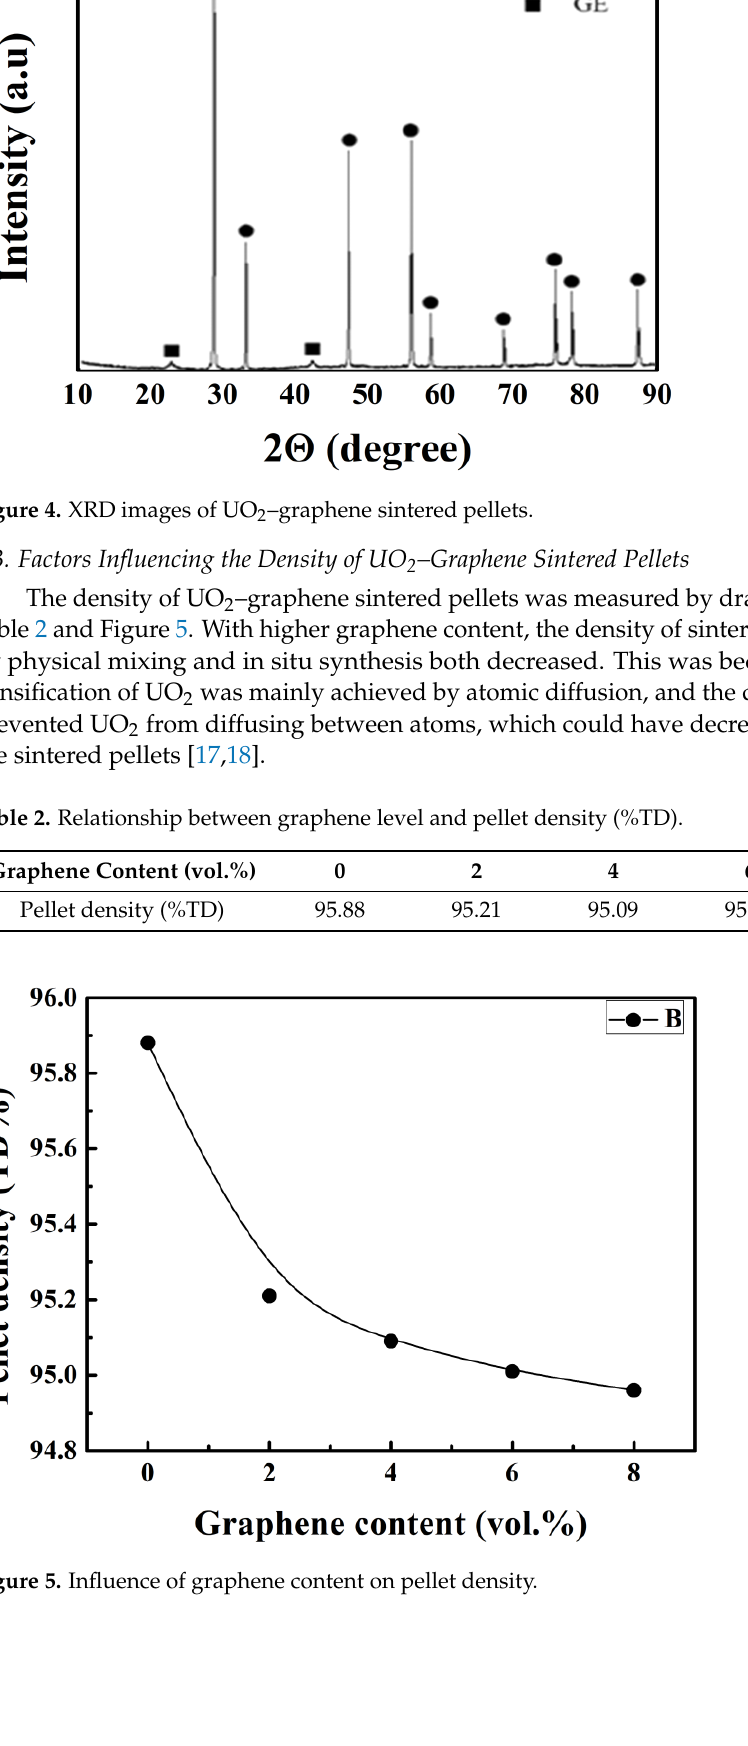
Figure 5. Influence of graphene content on pellet density.